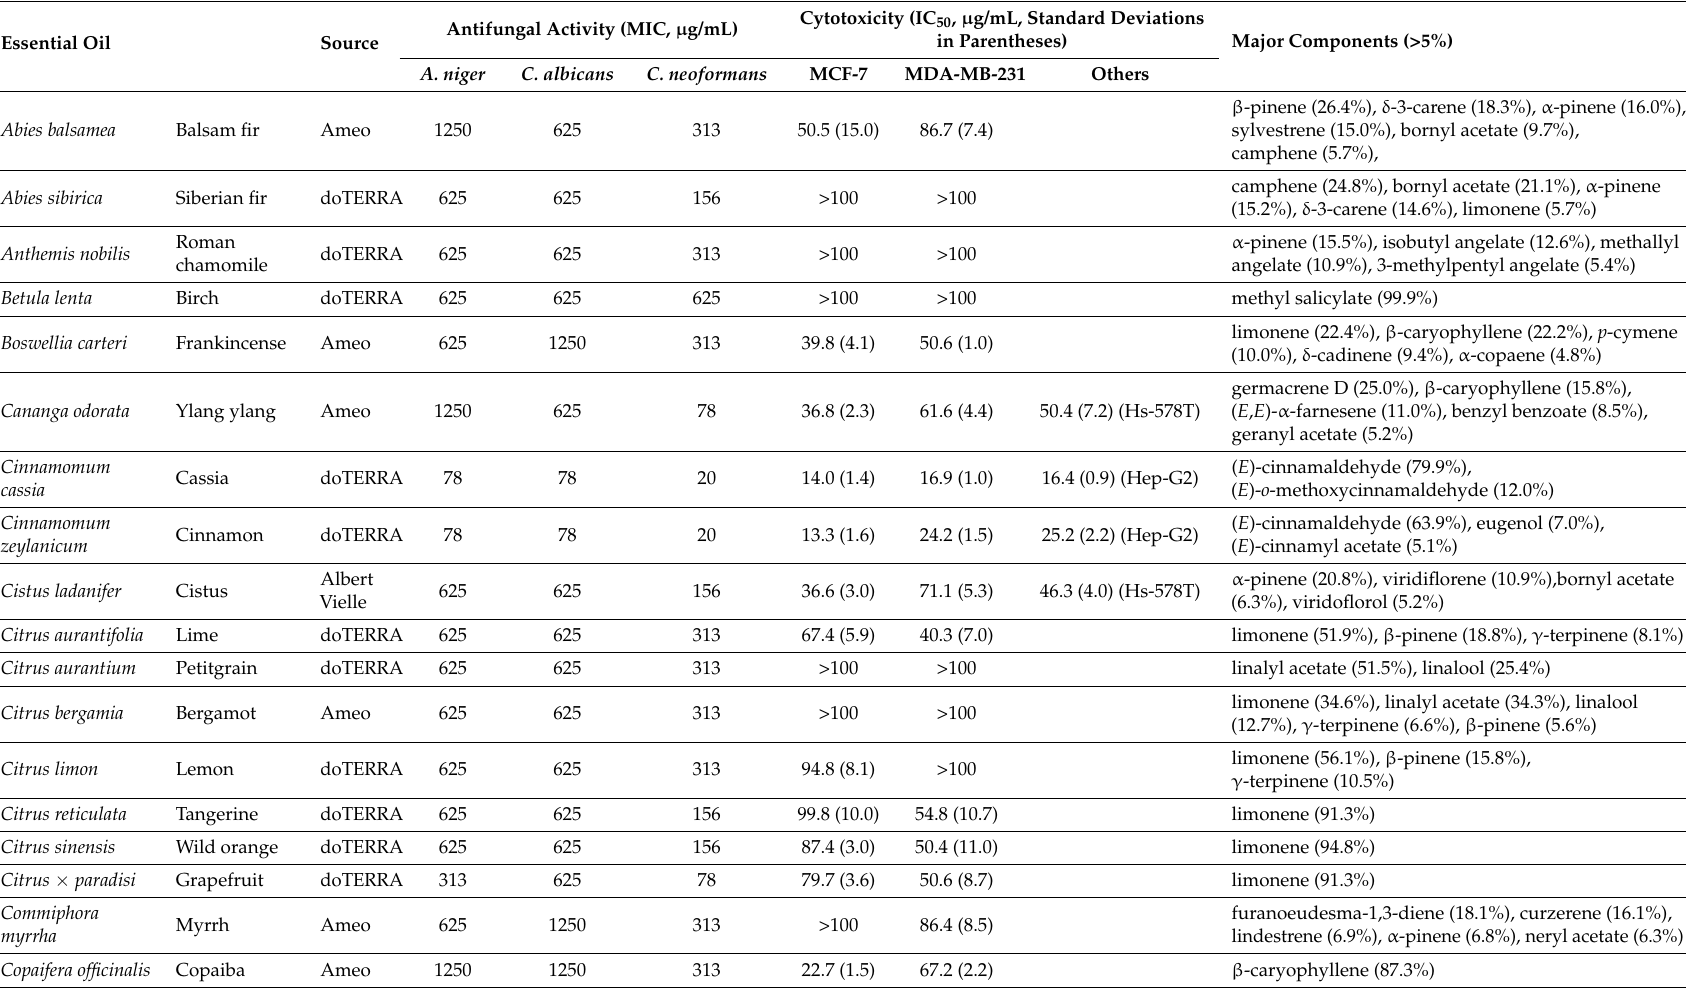
Table 1. Antifungal and cytotoxic activities and major components of sixty commercially-available essential oils. MIC—minimum inhibitory concentrations.